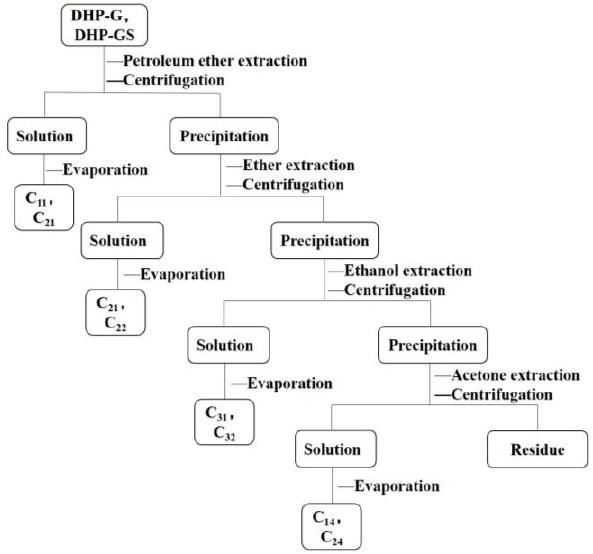
Figure 18. Classification flow chart of DHP-G and DHP-GS.